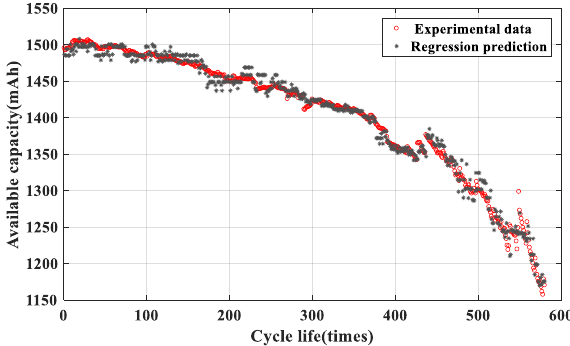
Figure 10. Original data vs. predicted data.